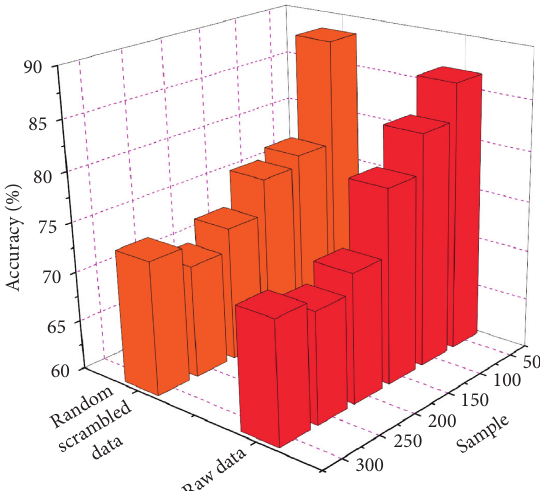
Figure 11: Accuracy rate of recognition results of the accounting fraud identification model.